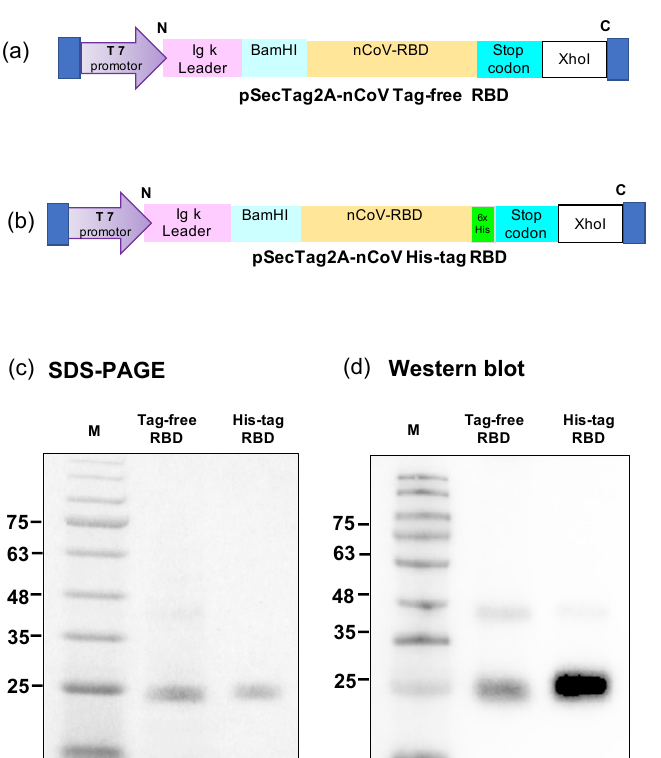
Figure 1. Tag-free RBD and His-tag RBD protein expression. Overview of the tag-free SARS-CoV-2 RBD ( a ) and His-tag SARS-CoV-2 RBD ( b ) construct design in pSecTag2A. The two recombinant SARS-CoV-2 RBD proteins were expressed in Expi293 cells and purified by FPLC. Proteins were analyzed with SDS-PAGE ( c ) and Western blotting with mouse anti-spike monoclonal antibody used for detection ( d ).